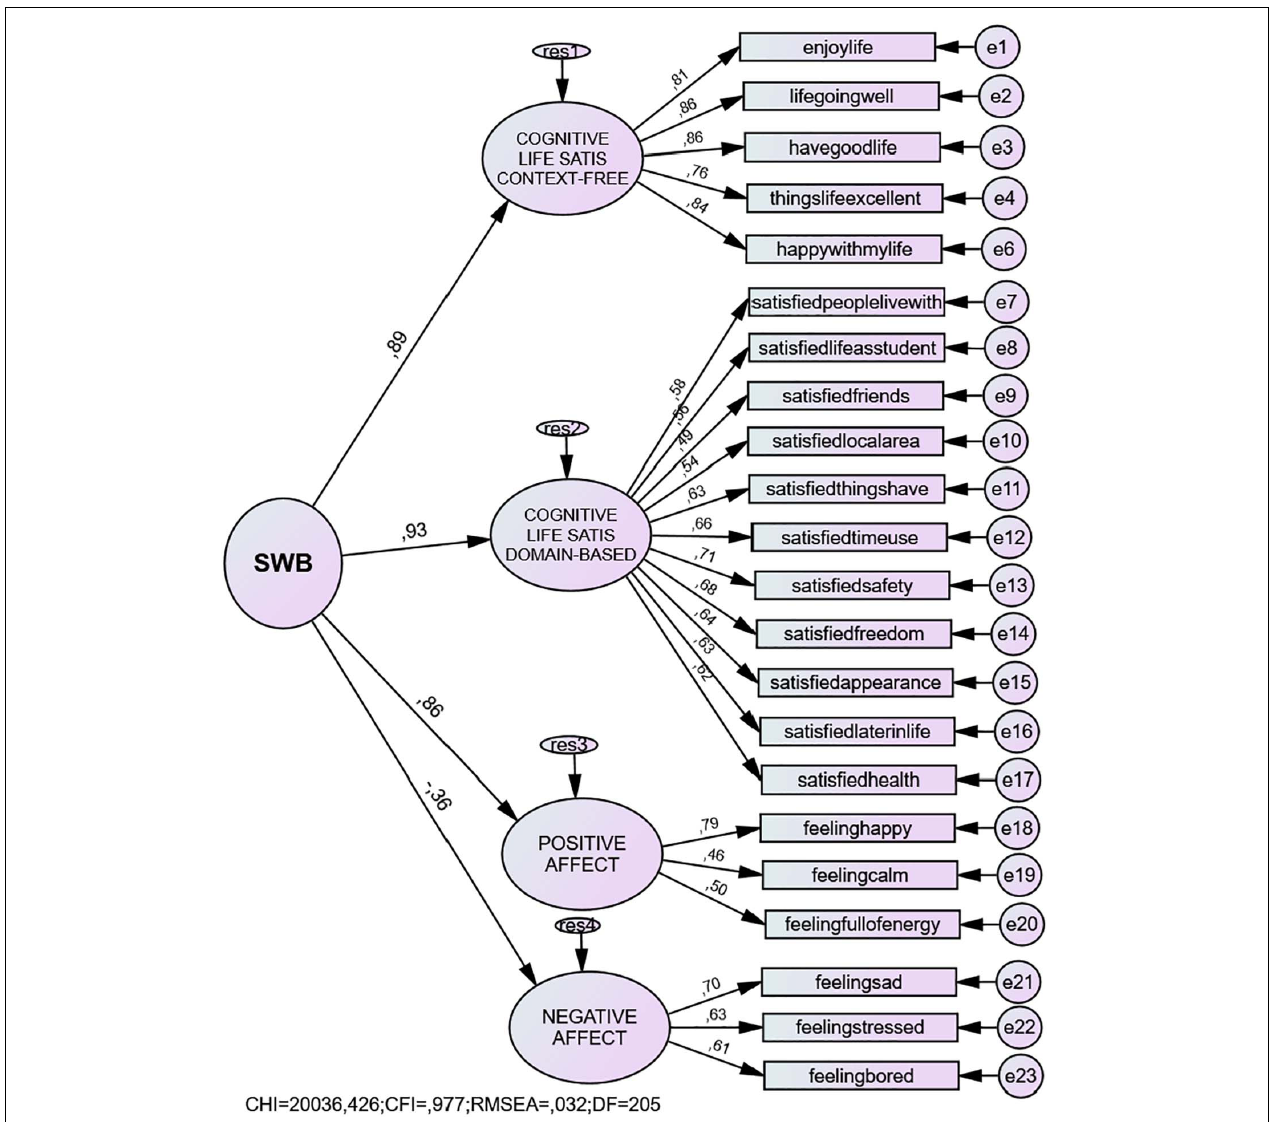
FIGURE 2 | Hierarchical structural model of children’s subjective